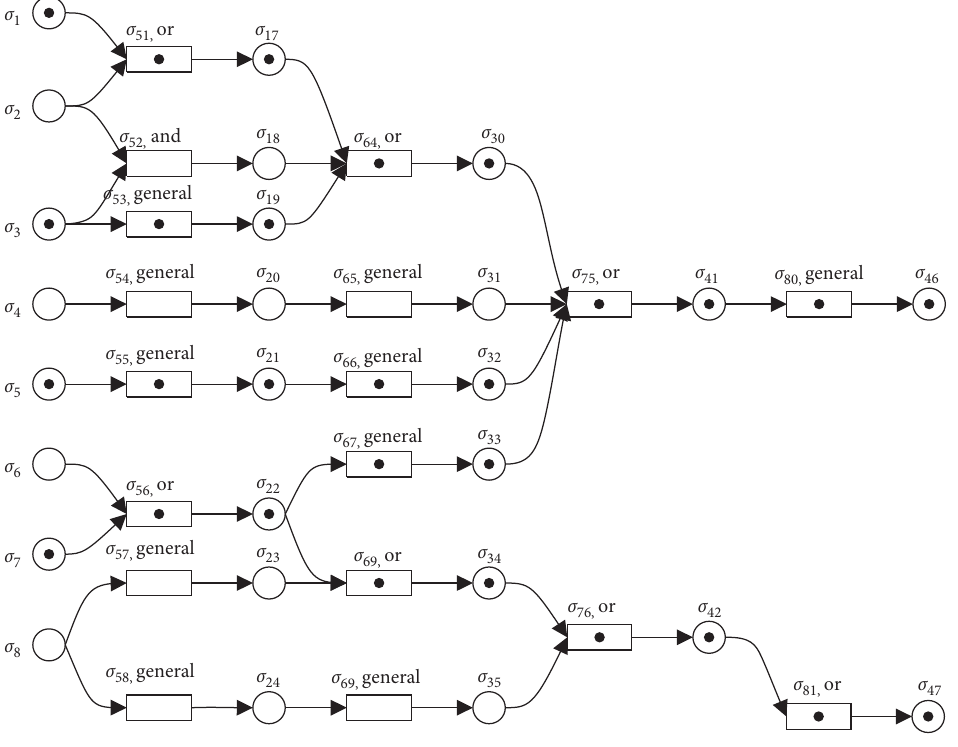
Figure 6: Forward prediction of potential fault